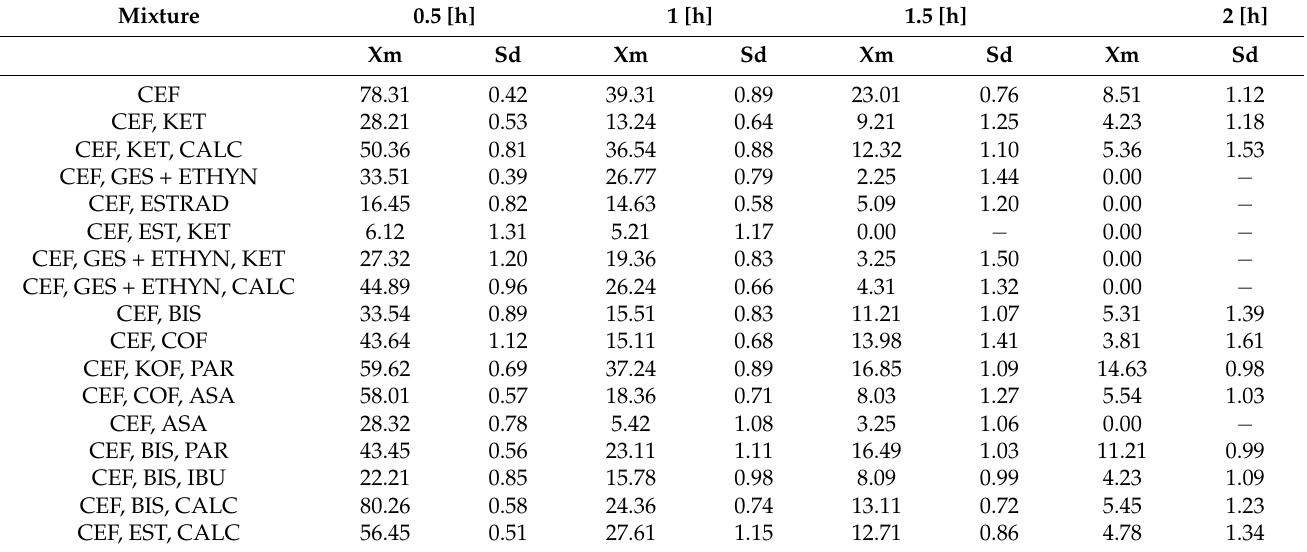
Table 3. Concentration [%] changes in cefepime in various drug mixtures after UV radiation ( n = 3).